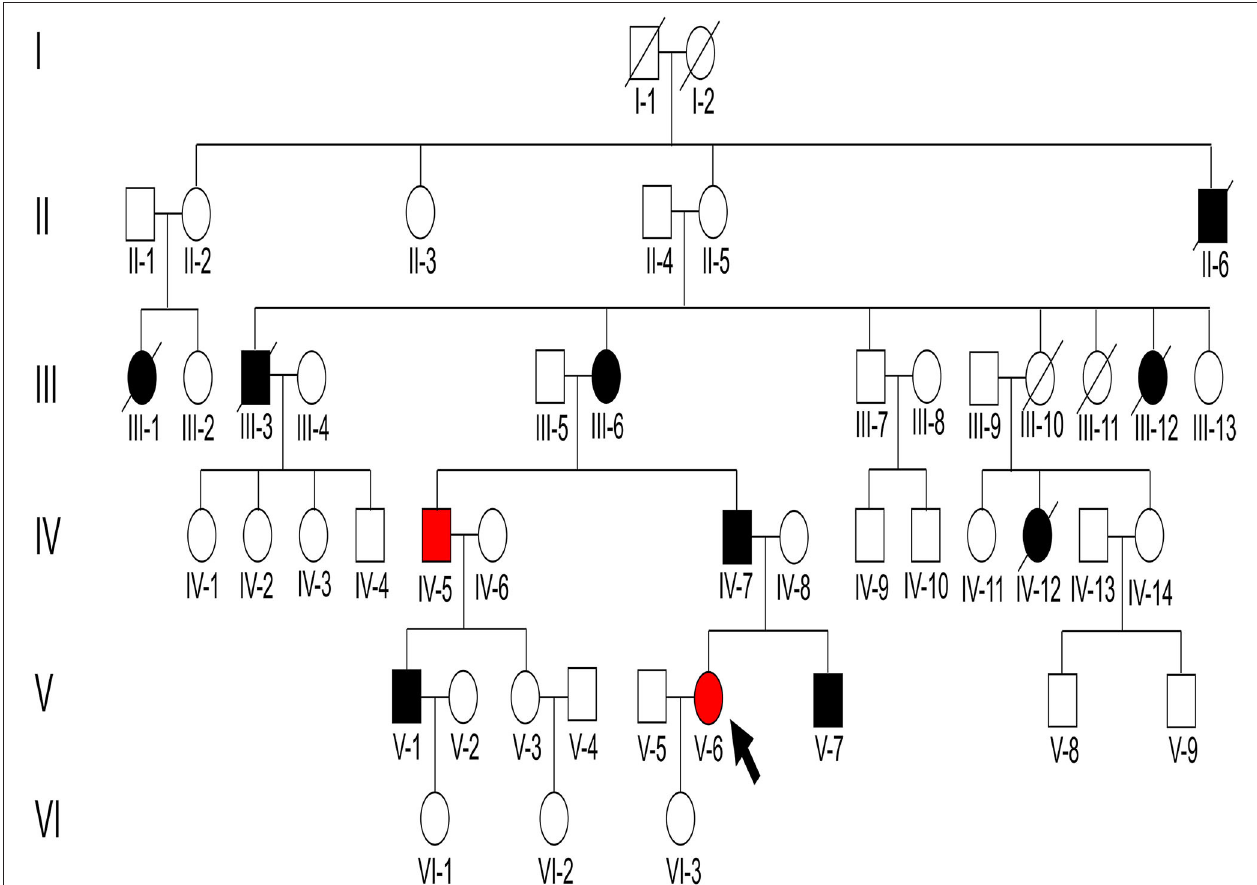
FIGURE 1 | Pedigree structure of the family with immunoglobulin A (IgA) nephropathy (IgAN). There were 47 individuals in the Chinese six-generation IgA pedigree with no close relatives that were married. The arrow indicates the proband, black-filled shapes indicate abnormal proteinuria and/or hematuria results, red-filled shapes indicate patients diagnosed as IgAN, and unfilled shapes indicate unaffected